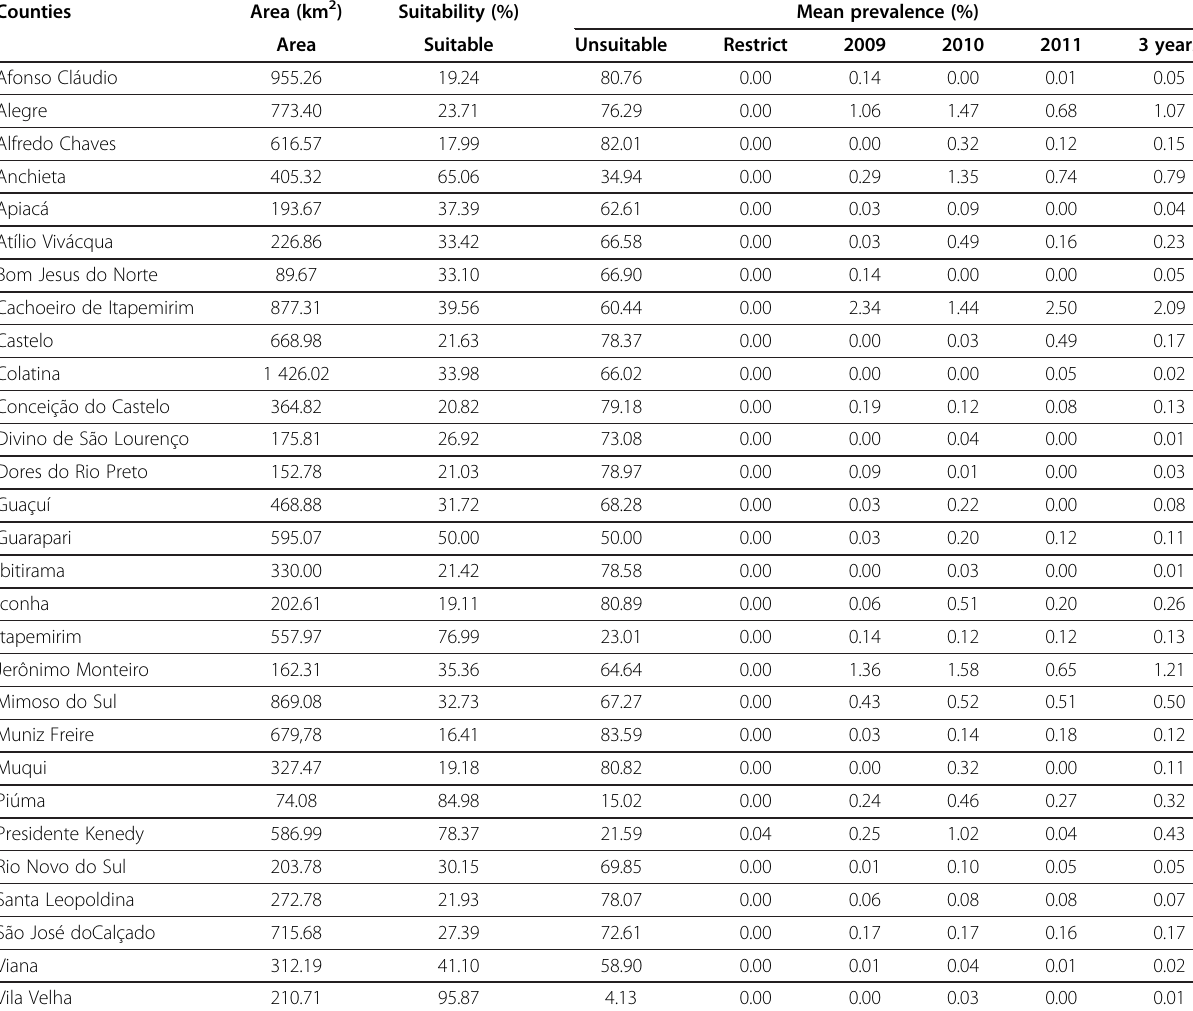
Table 3 Suitability for bovine fasciolosis and mean prevalence between 2009 and 2011 according to its origin by cities in the Espírito Santo